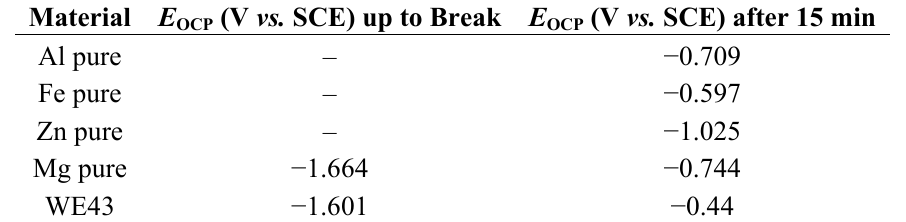
Table 1. Open circuit potentials after 15 min in Ringer’s solution. SCE, saturated calomel electrode.